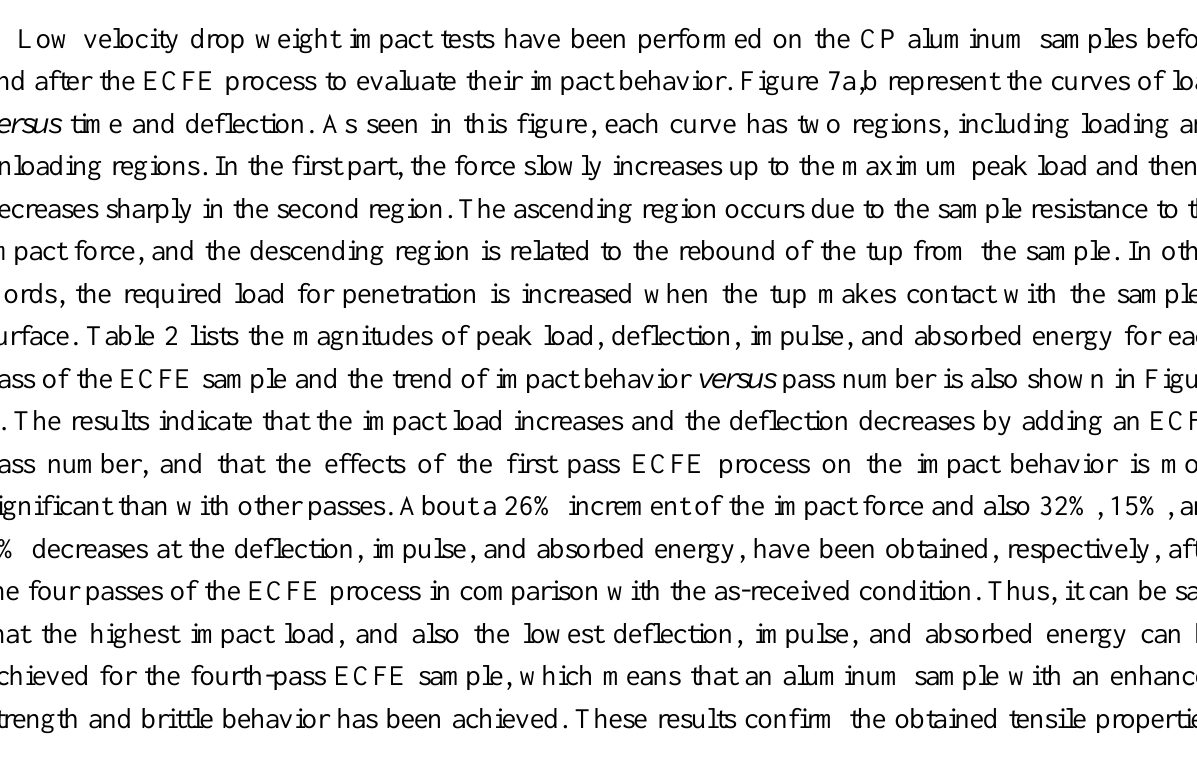
Figure 6. The variation of tensile properties, hardness behaviors, and impact characteristics of the CP aluminum, before and after the ECFE process, up to four